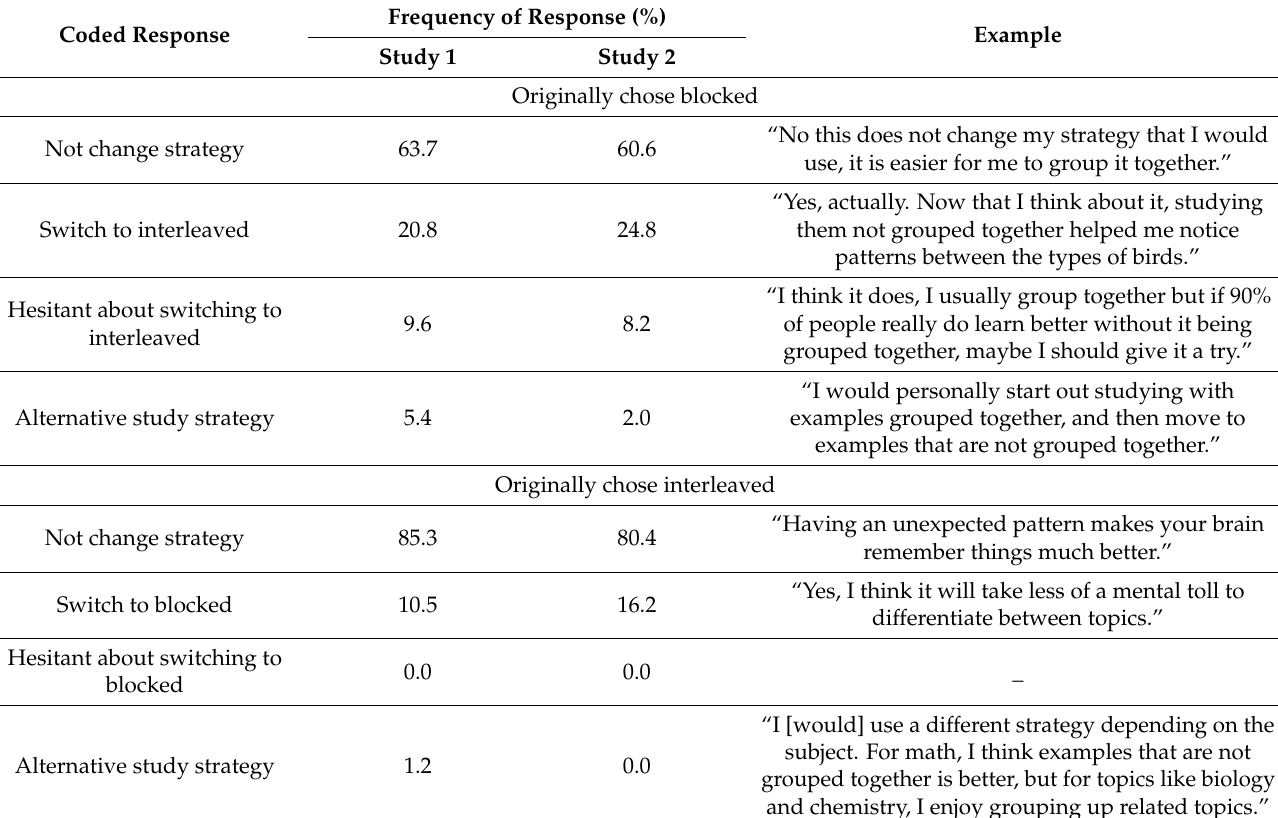
Table 1. Free-response regarding change in strategy